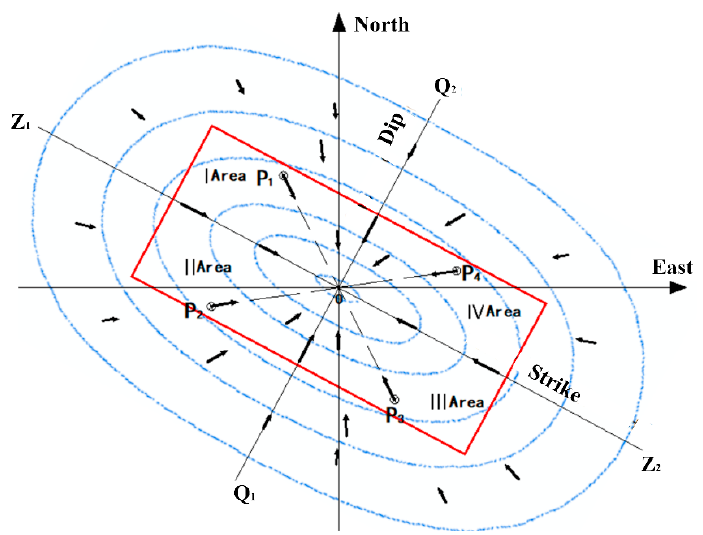
Figure 2. Vector map of subsidence and horizontal displacement of surface movement in the symmetrical basin area. The blue line is the settlement isoline and the red frame is the location of mined-out areas. The arrow is the horizontal displacement vector.